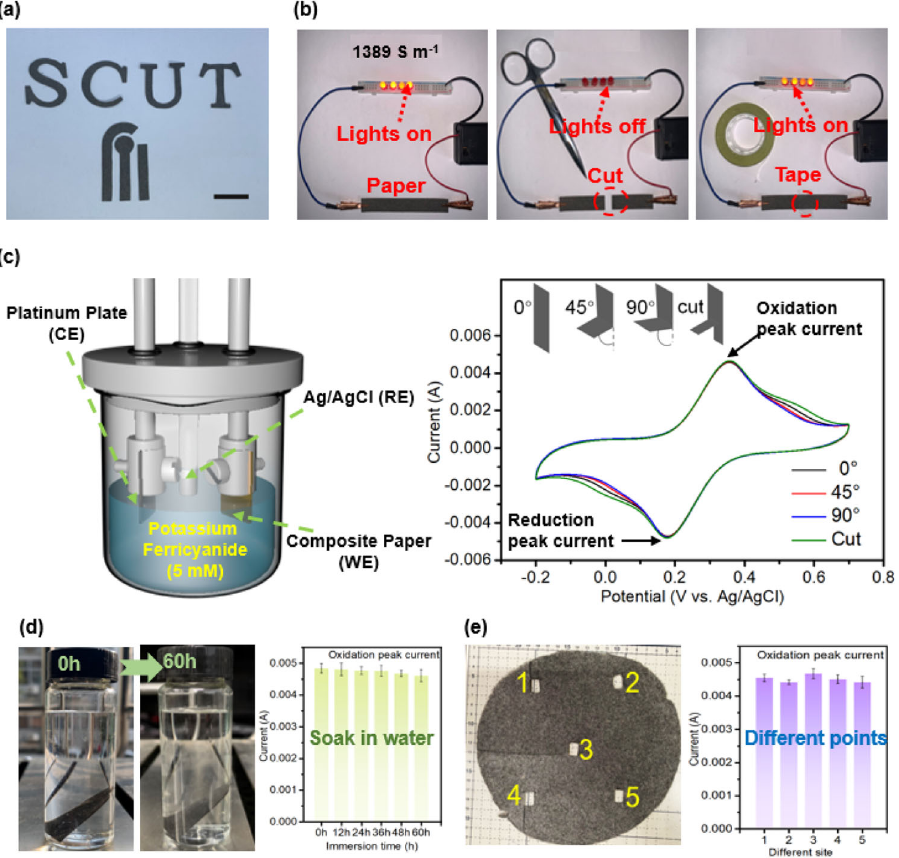
Fig. 4 Important features of CF/GO/cellulose composite paper. a Cut paper. Paper cutting allows reproducible generation of different patterns. Scale bar is 2 cm. b Repairability. The composite paper is conducting (conductivity value is 1389 S m − 1 ). Electrochemical measurements (of K 3 Fe(CN) 6 ) demonstrate that the CF/GO/cellulose composite is ( c ) fl exibility (CV of potassium ferricyanide). Electrochemically active and fl exible. d Stability. Structurally and functionally stable in water, and ( e ) repeatability. Repeatable in that different samples (i.e., different sensors) taken from different locations show the same functional